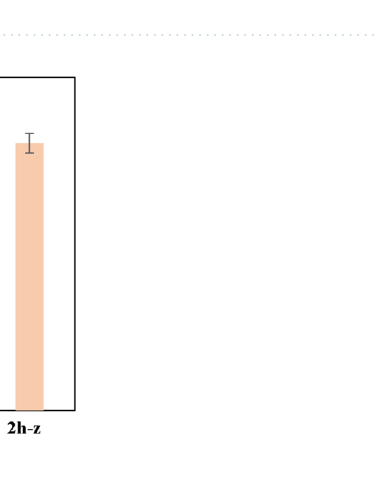
Figure 7. XRD spectra of the: ( a ′ ) BJP; ( a ″ ) 2 h-p-5 sample; ( a ‴ ) 1 h-CIP-3 sample; ( b , c ) SEM images of the 1st